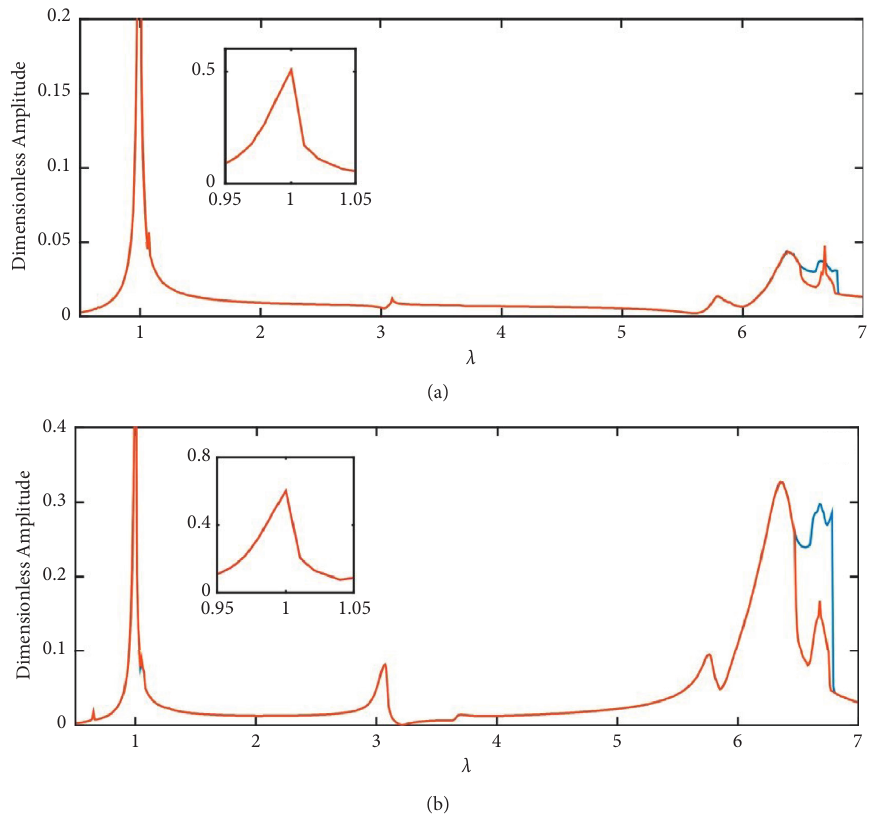
Figure 14: The amplitude-frequency curves of responses of (a) disc and (b) left-end journal in horizontal direction when N means run-up process and brown line means run-down process).